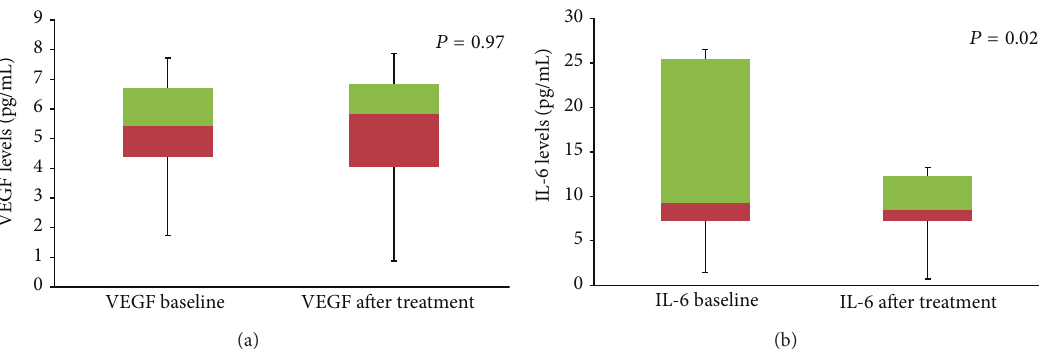
Figure 2: Box plot diagram showing the change in mean aqueous VEGF levels (a) and change in mean aqueous IL-6 levels (b) in patients in group 1. The error bar represents standard deviation.